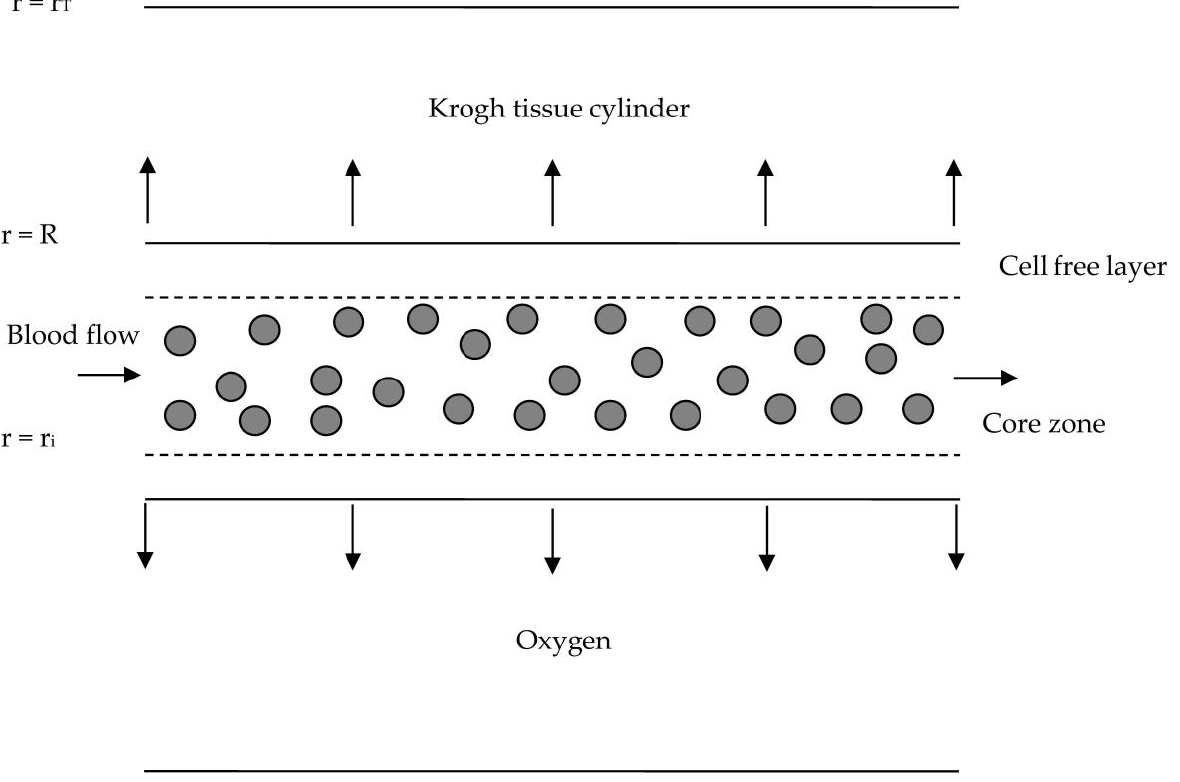
Figure 1. Schematic of oxygen transport from a microvessel to its Krogh tissue cylinder. The two zones introduced by Haynes are shown: a cell-free layer surrounding a core zone where RBCs con- centrate.